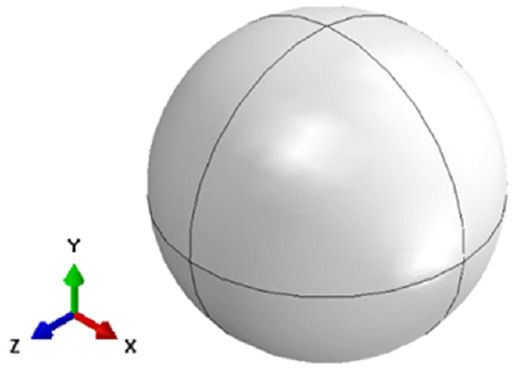
Table 4. Elastic steel properties of the 63T Sumo cable bolt.